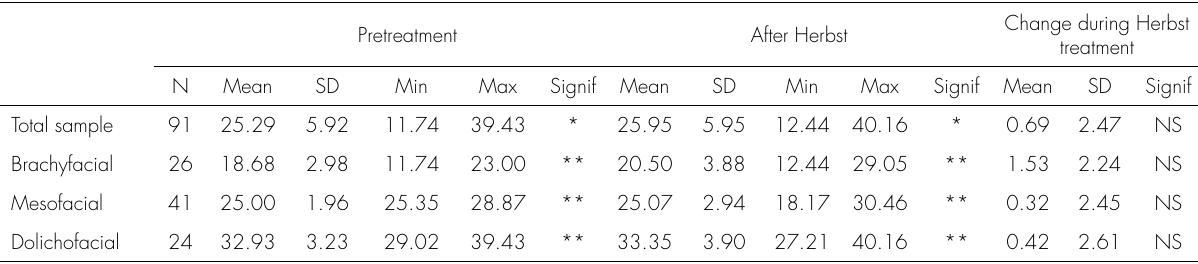
SD = Standard deviation, Min = minimum value, Max = maximum value, Signif = ANOVA, significant differences in means, NS = Not significant. * = p ≤ 0.05 ** = p ≤ 0.05, significant difference in vertical pattern subgroup Table XI. Mandibular plane angle (degrees).